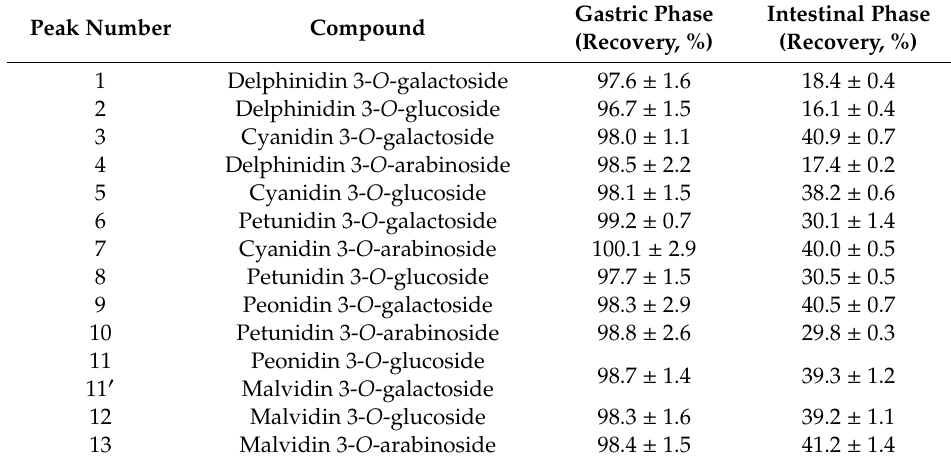
Table 2. Impact of simulated digestion on anthocyanin composition of Vaccinium myrtillus fruit extract. Peak Number